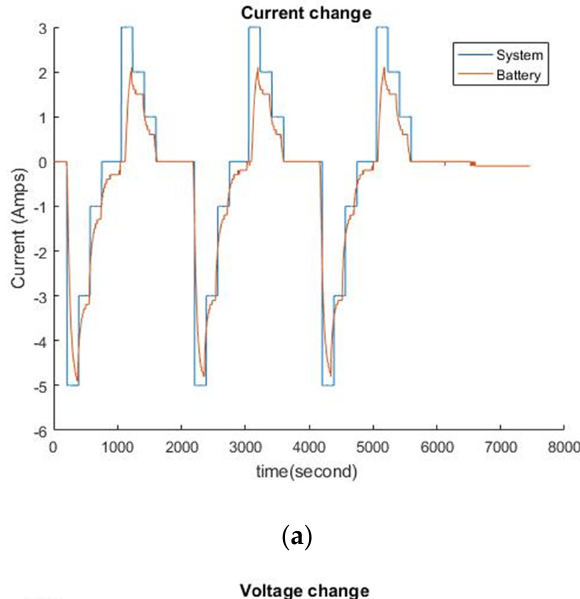
Figure 5. ( a ) Voltage drop vs. duty ratio in constant-current discharge: ( b ) voltage drop vs. duty ratio in pulse discharge.